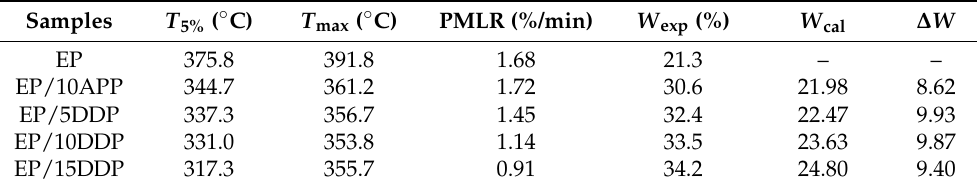
Table 2. Thermal parameters of the flame-retarded EP blends under a nitrogen atmosphere at a heating rate of 10 ◦